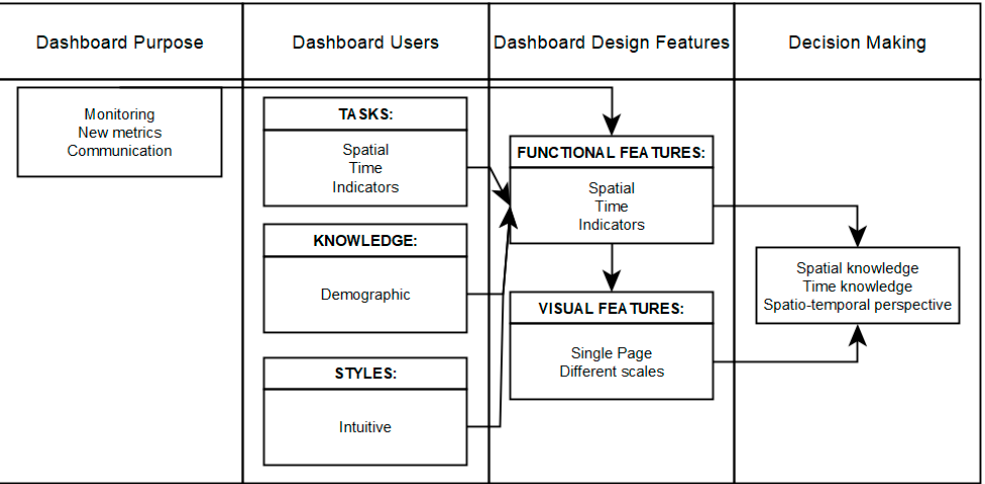
Figure 1. Dashboard research paths.